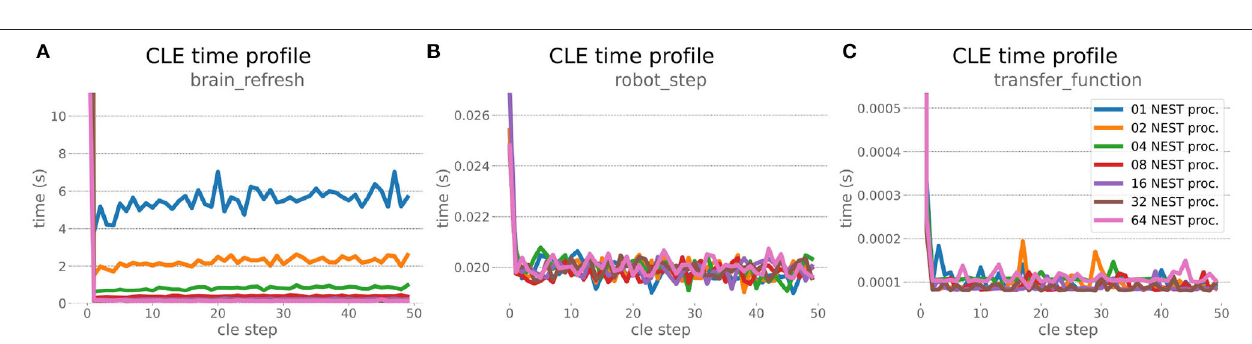
FIGURE 9 | HPC Benchmark CLE profiler times. Robot (B) and transfer function (C) execution times do not change during the scaleup, as they are not parallelized and just run on the first compute node in the allocation. Both are neglectable compared to the brain step time (A) that runs faster with additional compute nodes. The first timestep includes additional initialization procedures and hence takes significantly longer than the usual runtime step time, in the diagrams we clip the y-axis for better visibility of the relevant runtime data.